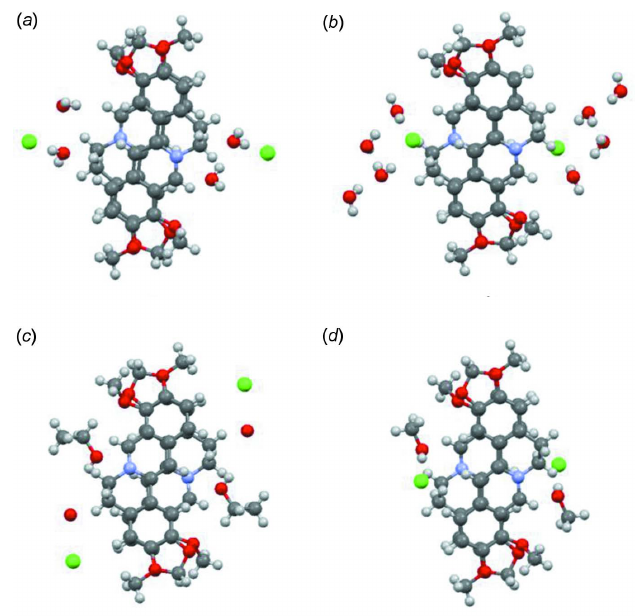
Figure 2 The dimers of berberine cations in the pseudopolymorphs with ( a ) two water molecules, ( b ) four water molecules, ( c ) one molecule of ethanol and 0.5 molecules of water, and ( d ) one methanol molecule (see text for